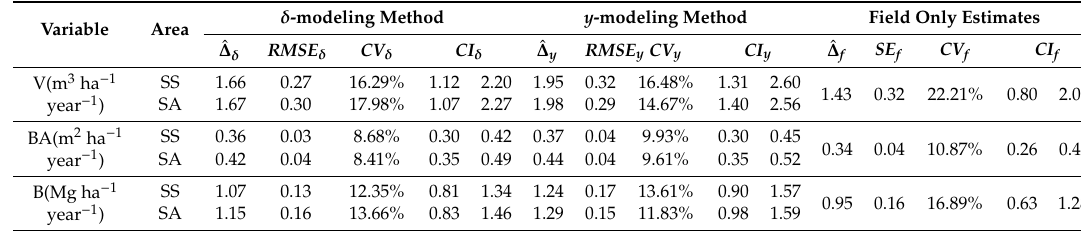
Table 4. Average increments of volume V, basal area BA and biomass B in the entire study area excluding the thinned stands (SA) and for the union of the sampled stands (SS). Estimates ( ˆ ∆ ) , root mean square errors ( RMSE ) , coe ffi cients of variation ( CV ) and confidence intervals ( CI ) obtained using the δ -modeling method and the y -modeling method are compared to estimates ( ˆ ∆ f ), standard errors ( SE f ) coe ffi cients of variation ( CV f ), and confidence intervals ( CI f ) using only the field